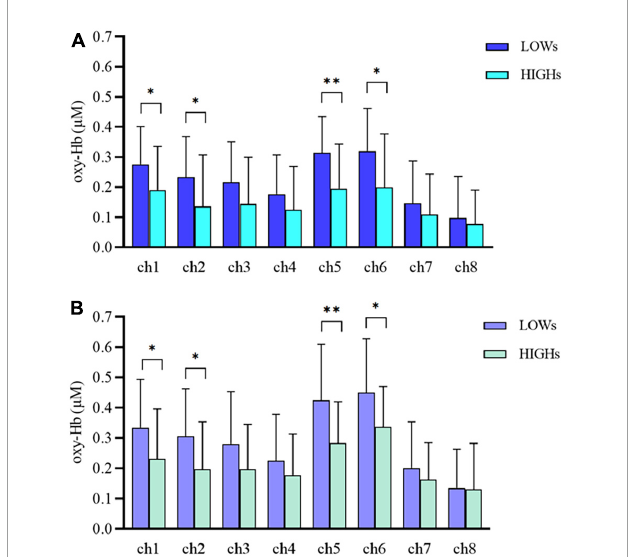
FIGURE4 Oxygenated hemoglobin (Oxy-Hb) concentration changes in prefrontal cortex (PFC) during the 1-back (A) and 2-back (B) tasks within LOWs and HIGHs. The bar graph from ch1 to ch8 showing the mean oxy-Hb concentration value in each channel. LOWs, the low rMSSD group; HIGHs, the high rMSSD group; ch, channel. The horizontal bars represent means ± SD. ∗ Bonferroni-adjusted P < 0.05 and ∗∗ Bonferroni-adjusted P <